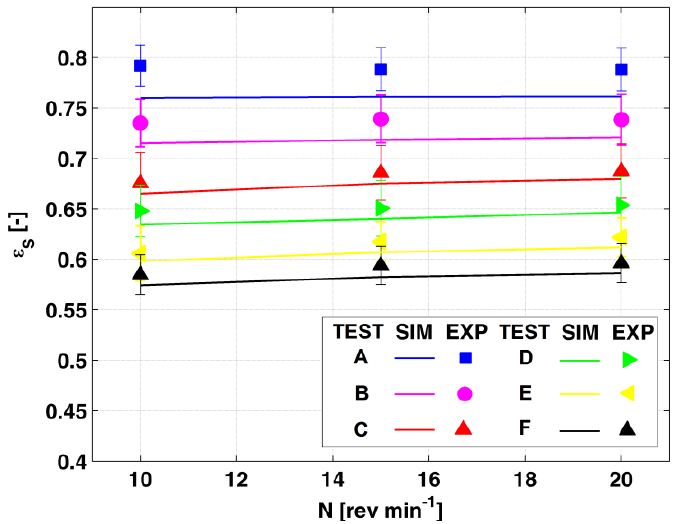
Figure 4. Pressure drop: experimental data and simulation results at